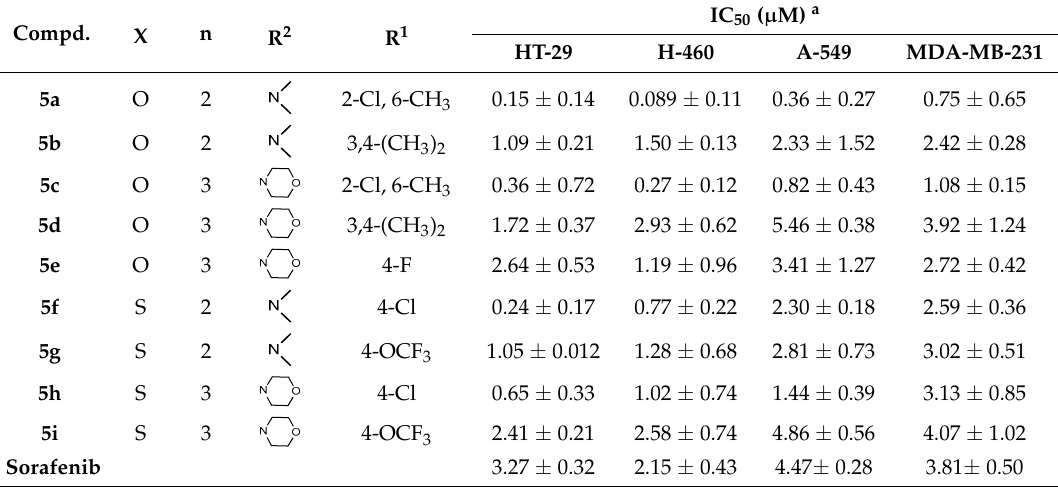
Table 1. Structures and cytotoxicity of compounds 5a – i against HT-29, H-460, A-549, and MDA-MB-231 cells in vitro.